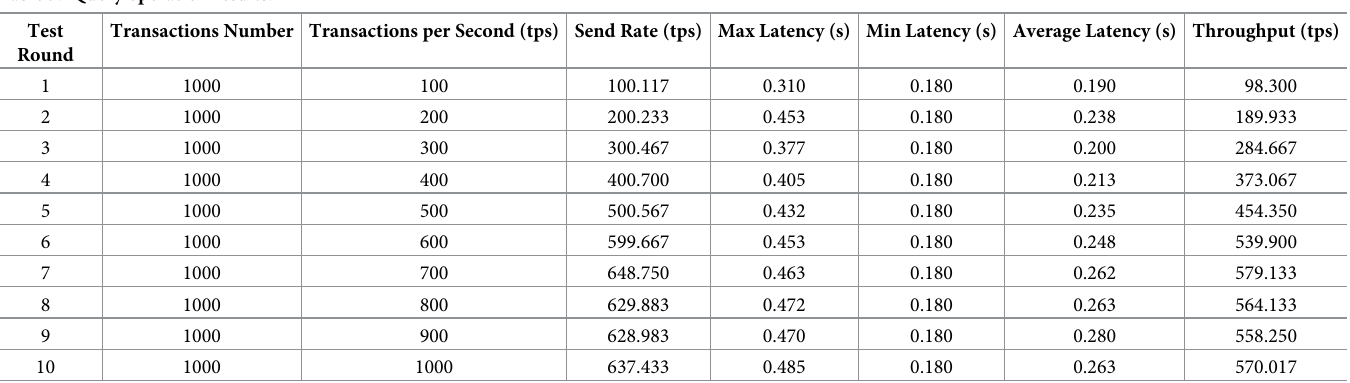
Table 7. Query operation results.